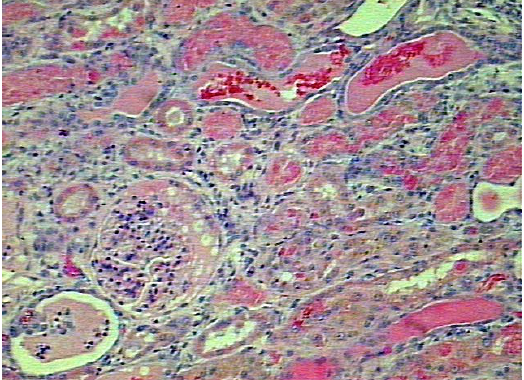
Figure 3. Histological section of the kidney: glomerular hypercellularity; Bowman’s capsule with high amount of proteins; proximal renal tubules with high amount of proteins and erythrocytes; and tubular degeneration (hematoxylin and eosin stain,